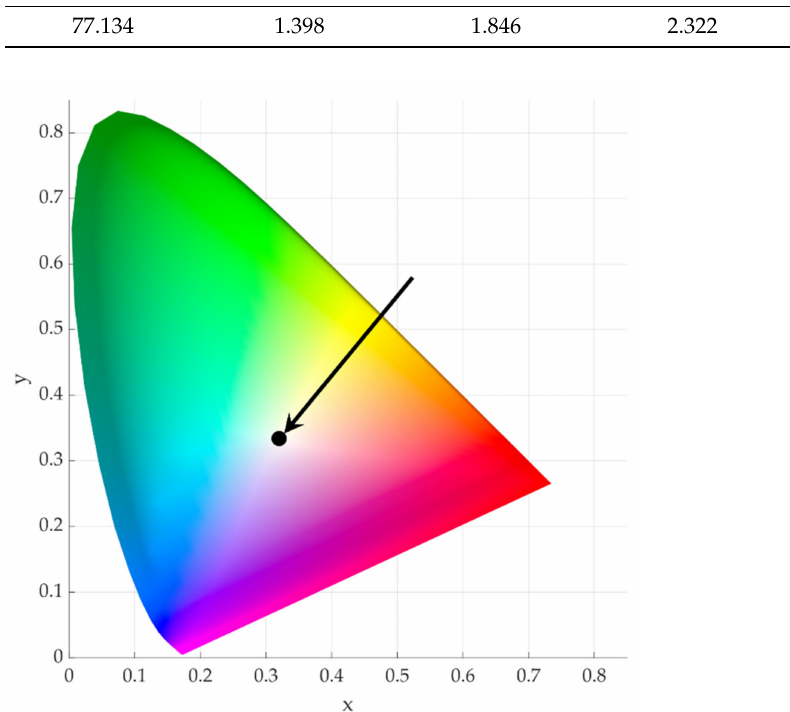
Figure 13. Chromaticity diagram, showing the measured colour of Ni/Y 2 O 3 nanocomposite